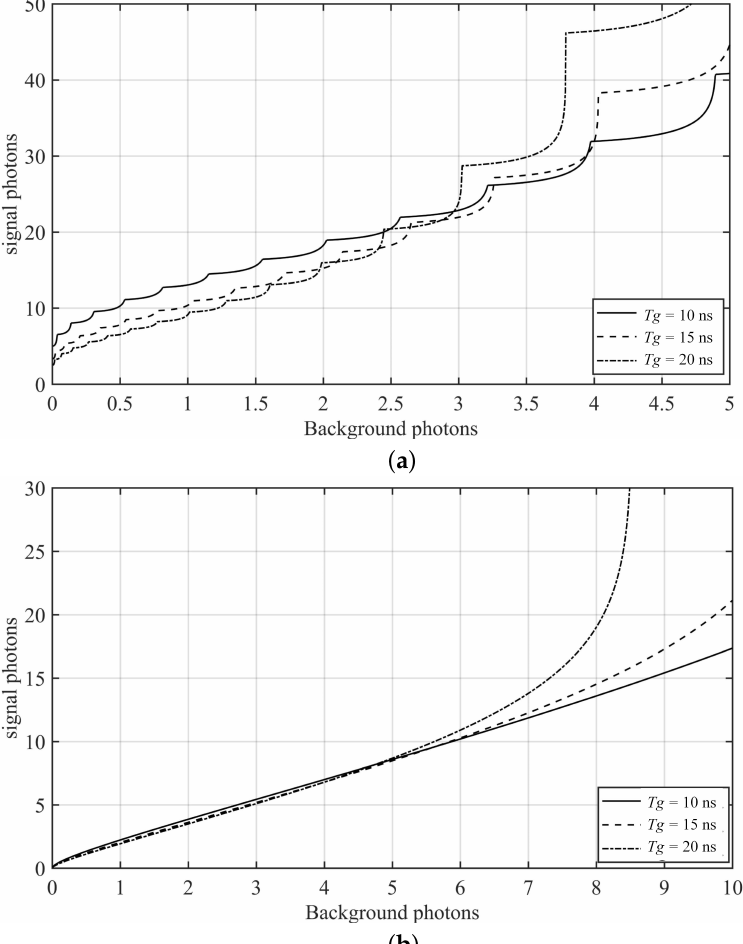
Figure 5. Background photons and signal photons required to achieve the target BER. ( a ) N g = 16. ( b ) N g =